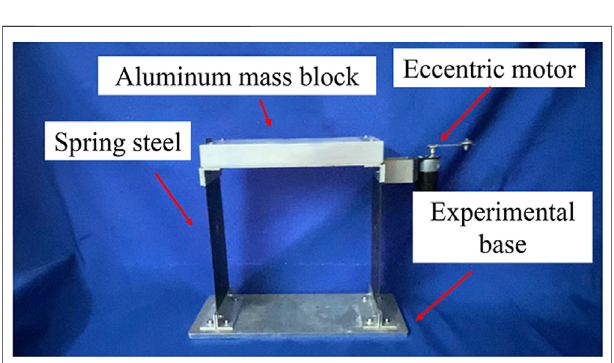
FIGURE 4 | Portal frame and its components.